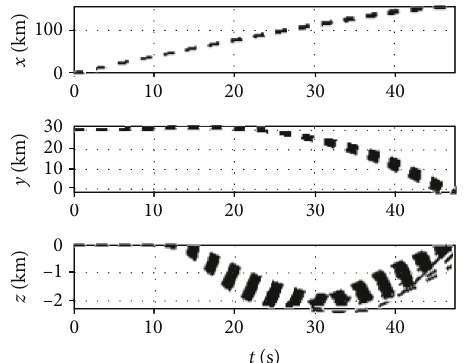
Figure 20: Curves representing the fi n de fl ections.